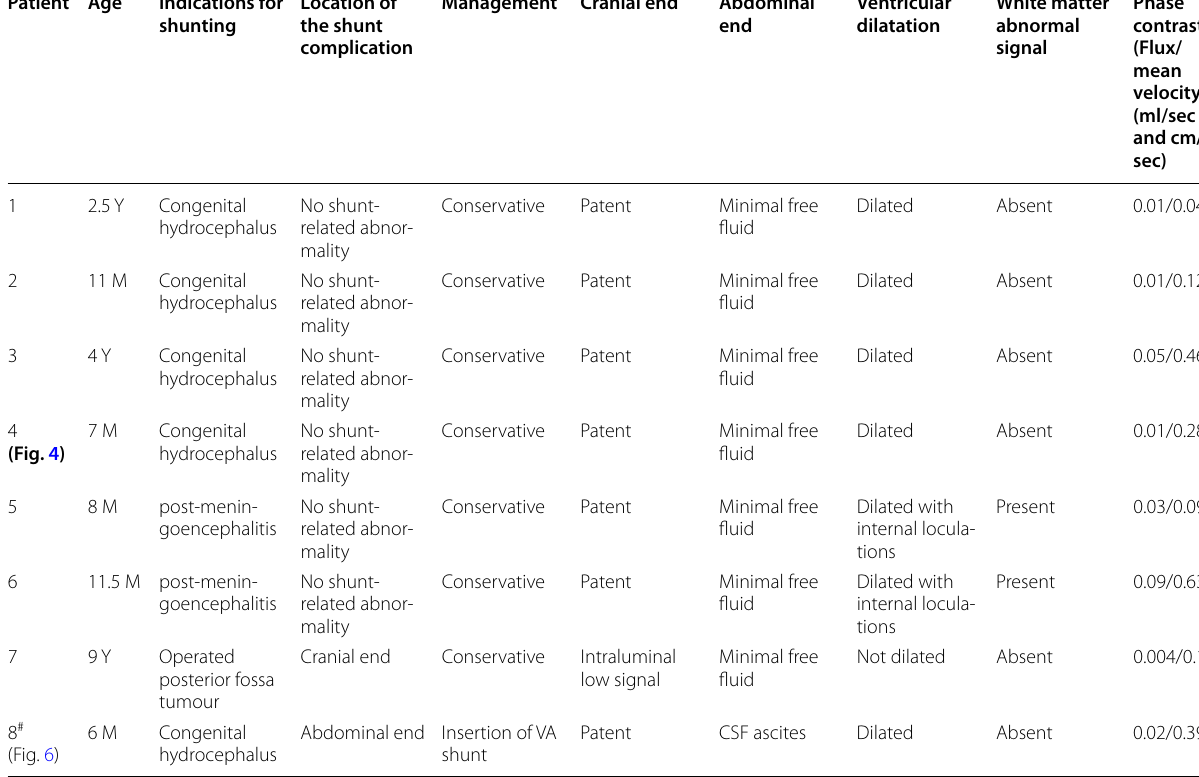
Table 2 Clinical and MRI findings of asymptomatic